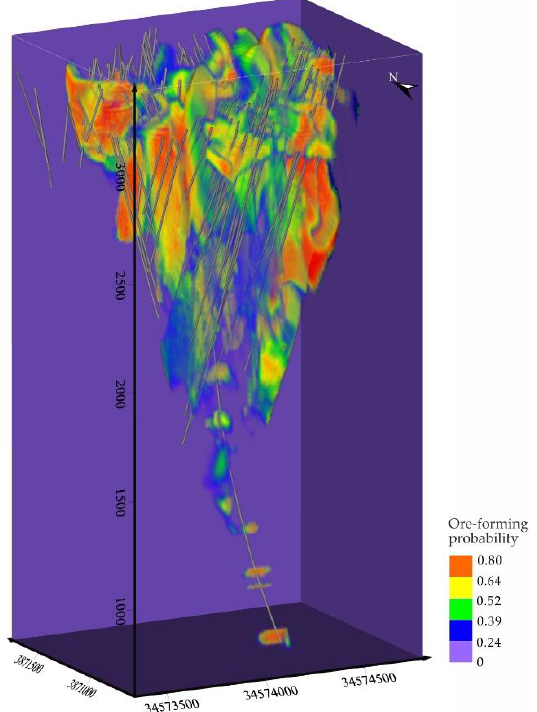
Figure 11. STOAD-based 3D MPM.